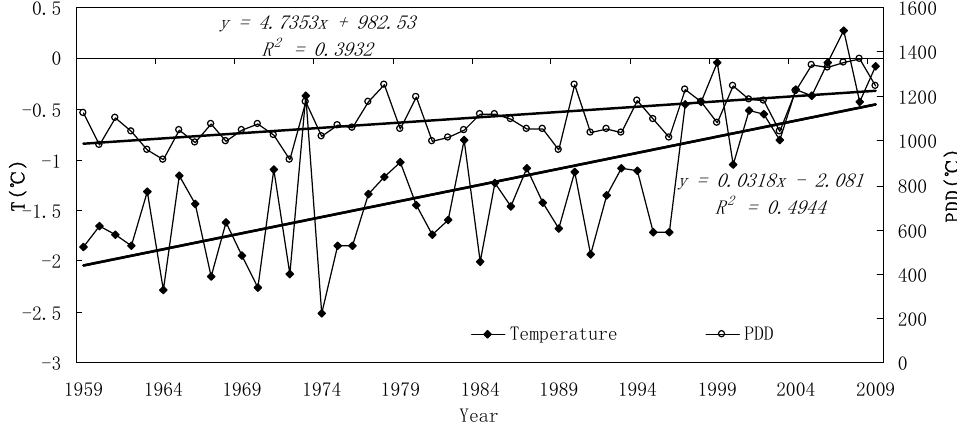
Figure 5. Reconstructed yearly average air temperature ( T ) and positive degree-days (PDD) at Camp-AWS over the period 1959–2009.